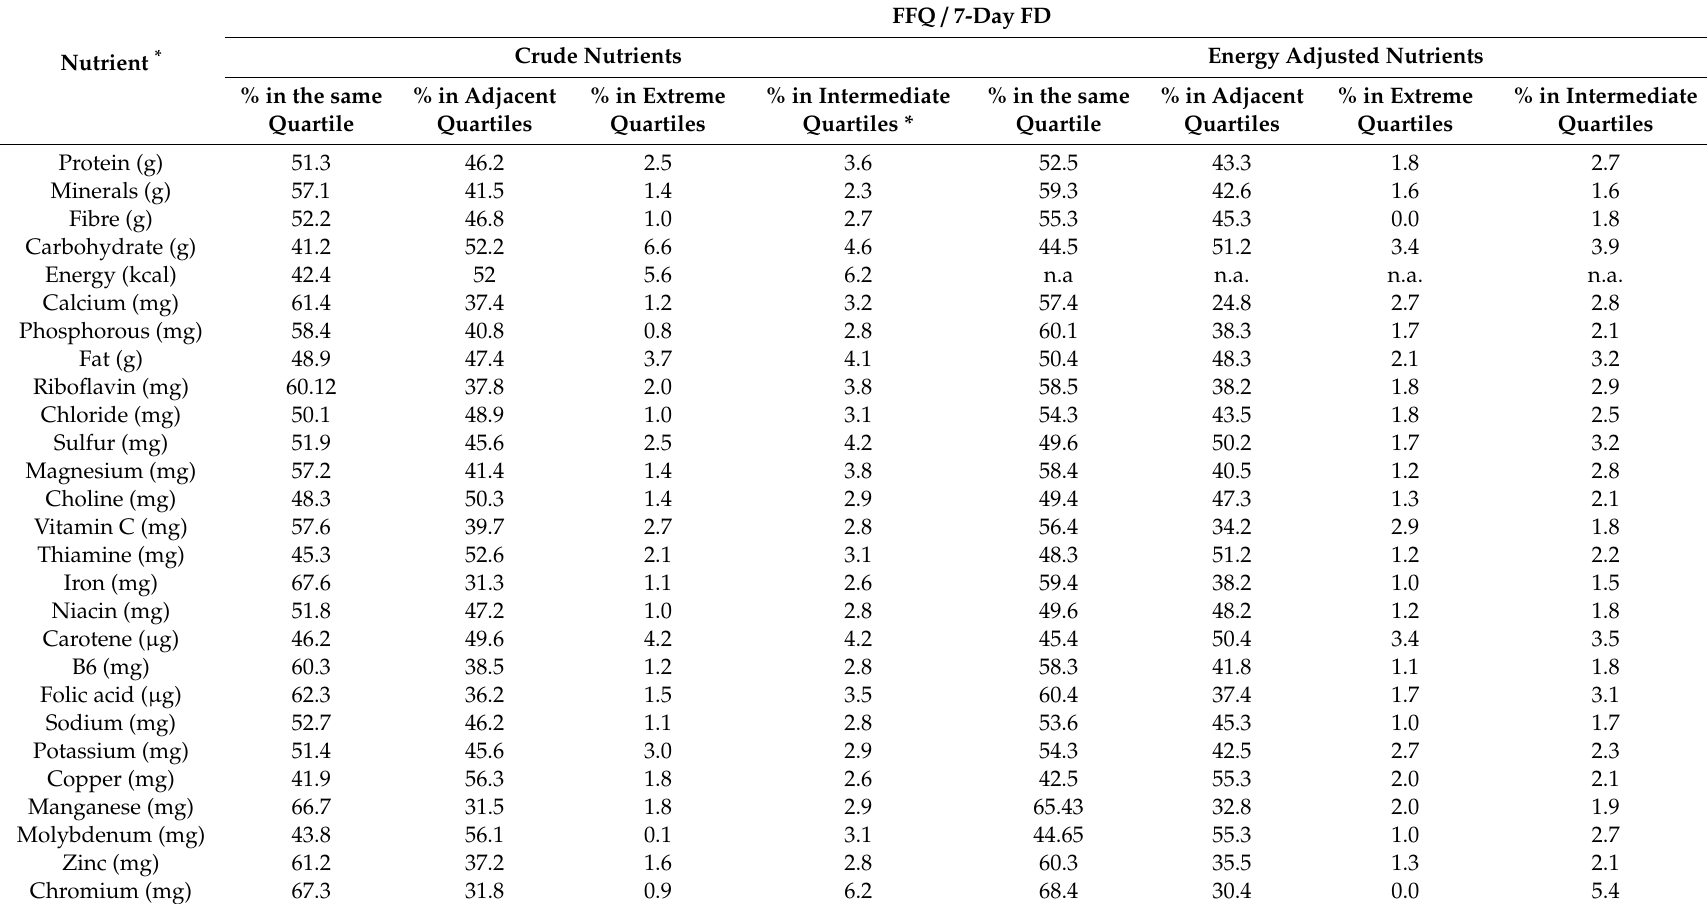
Table 5. Cross classification of quartiles by 124 food items listed food frequency questionnaire (FFQ) and the 7-day food